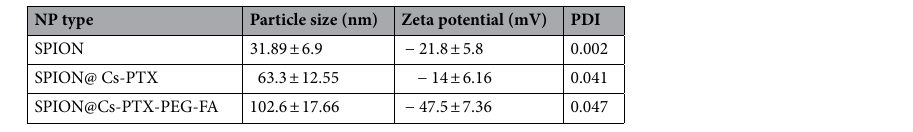
Table 7. Particle size and surface charge of SPIONs, SPION@Cs-PTX, and SPION@Cs-PTX-PEG-FA.